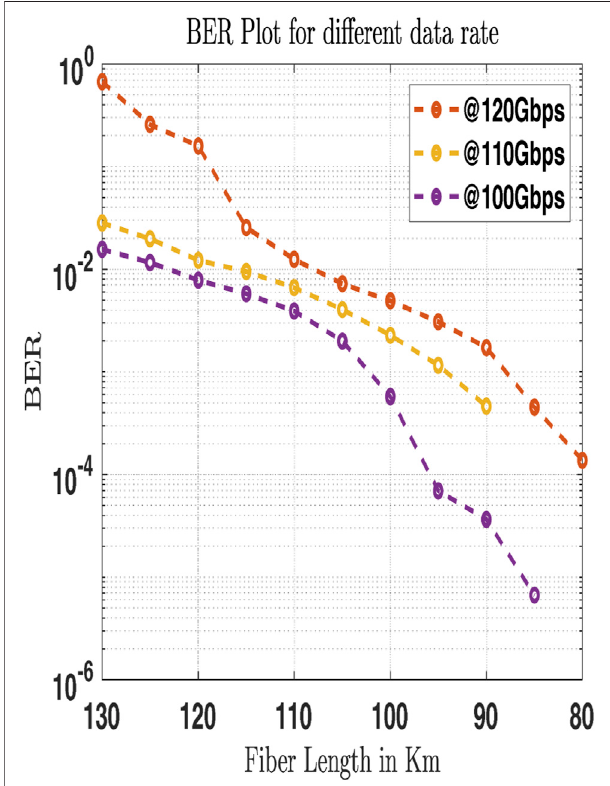
FIGURE 10 | BER vs fi ber length.